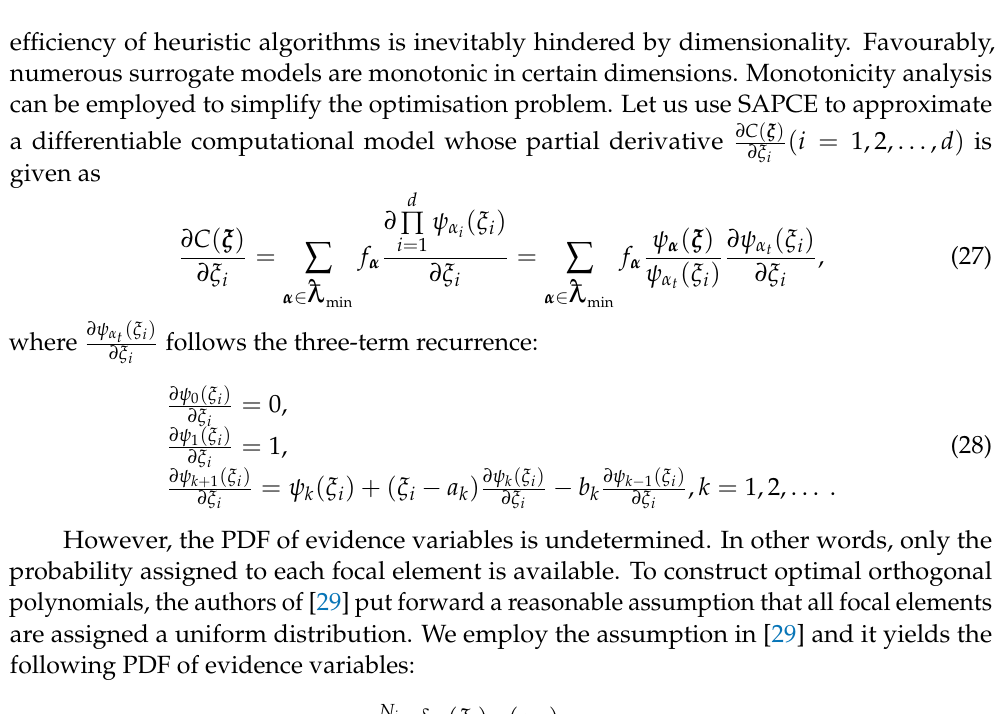
Figure 2. Framework of the SSR-ETM and ETM.